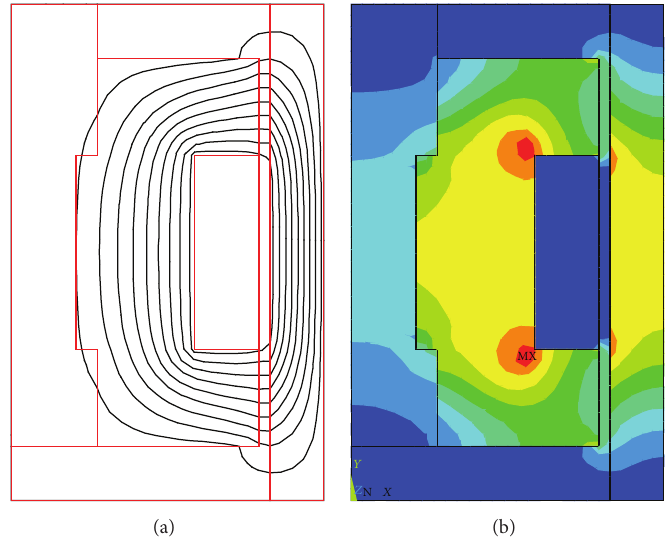
Figure 4: Finite element analysis of MR damper part: (a) magnetic flux distribution and (b) magnetic flux